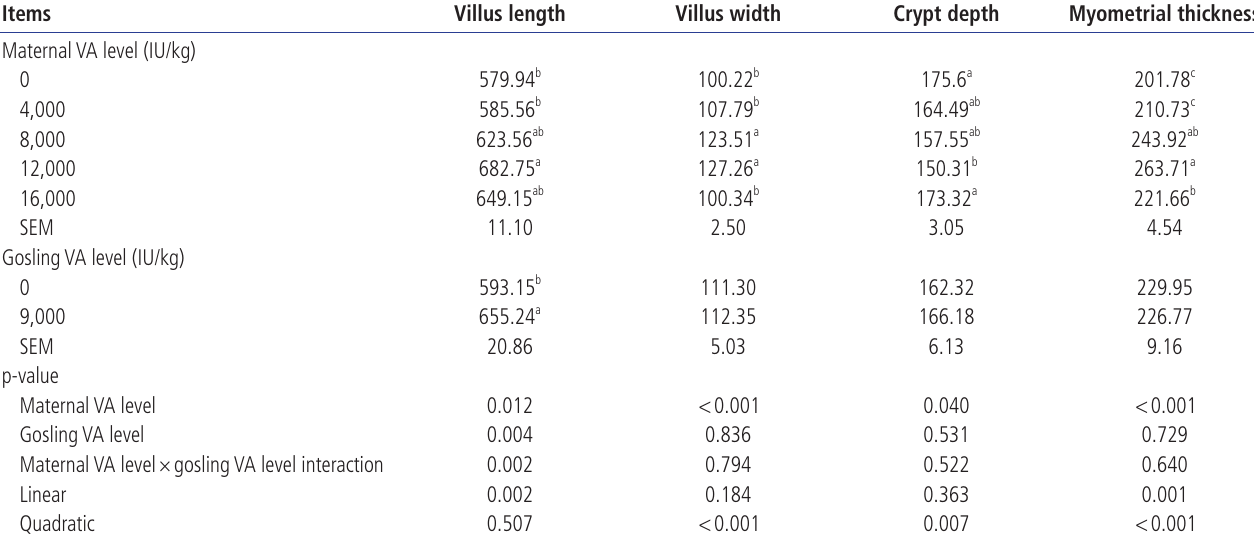
Table 2. Effects of different levels of vitamin A in maternal and offspring diets on duodenal morphology in goslings (μm)